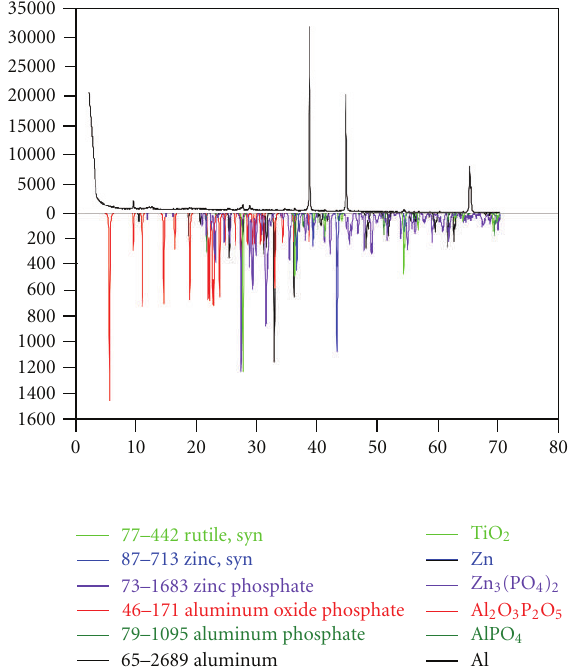
Figure 13: Spectrum of the double-layer system with